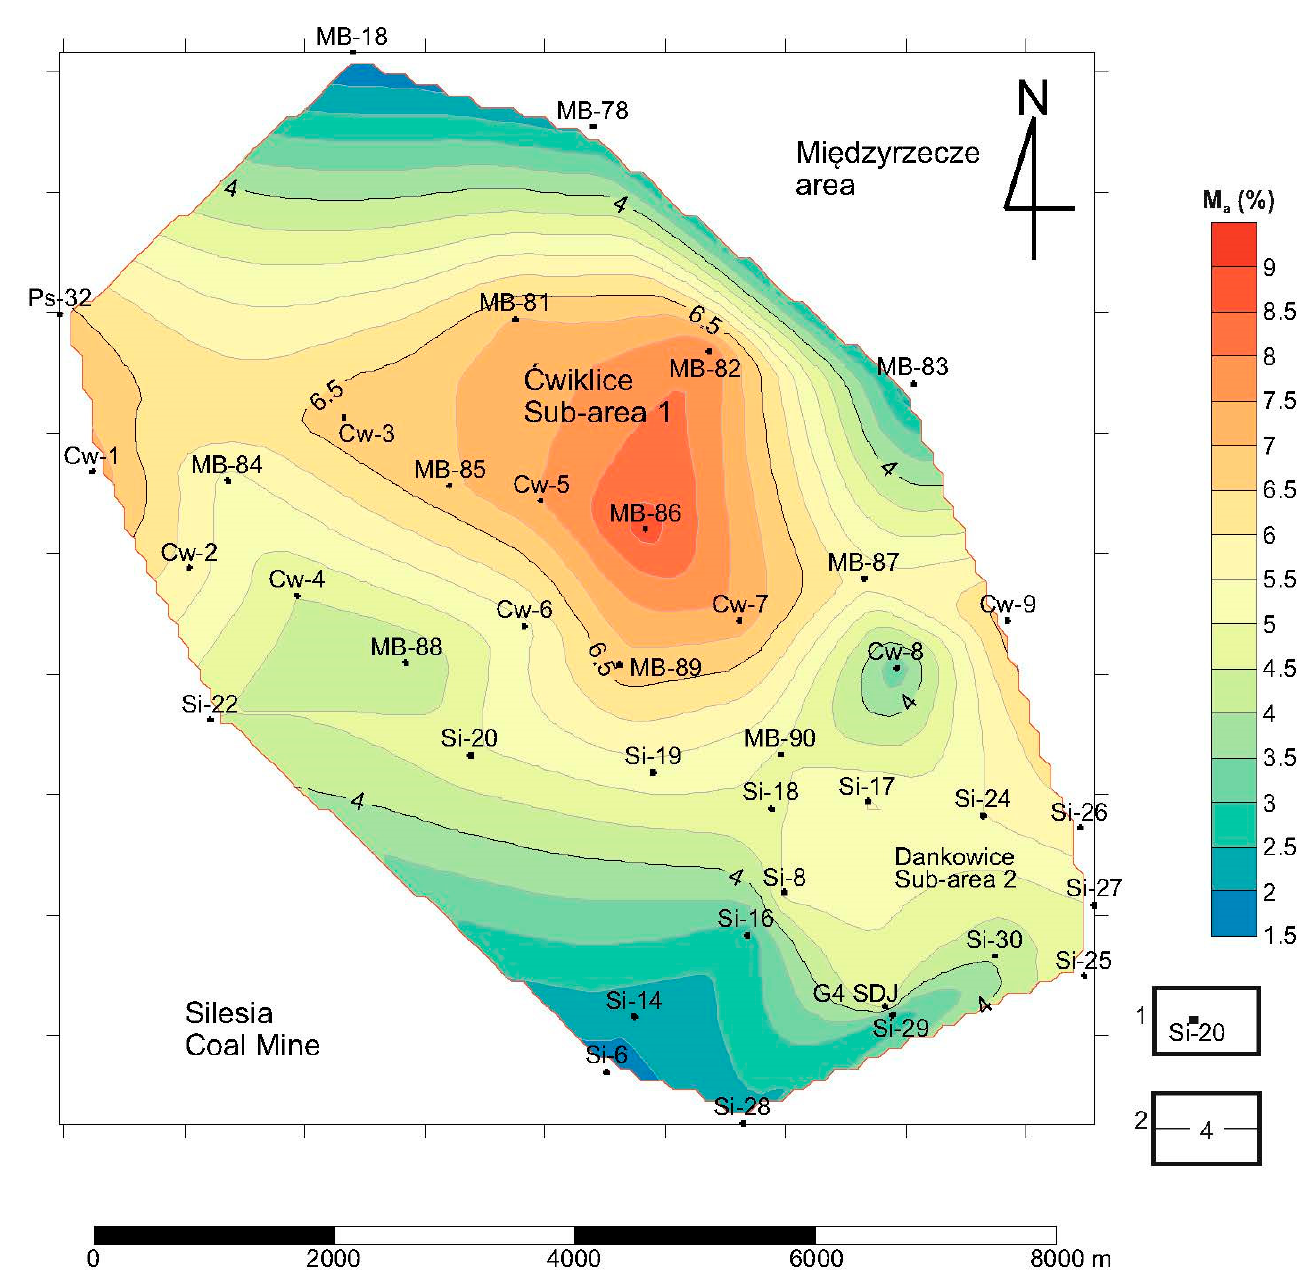
Figure 8. Moisture-content (M a ) distribution at the 800 m level below ground; 1—borehole, 2—important faults.